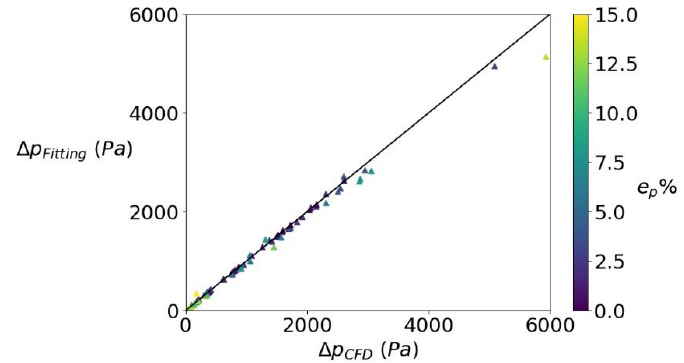
Figure 18. Comparison between the pressure drop from CFD simulations and fitting.